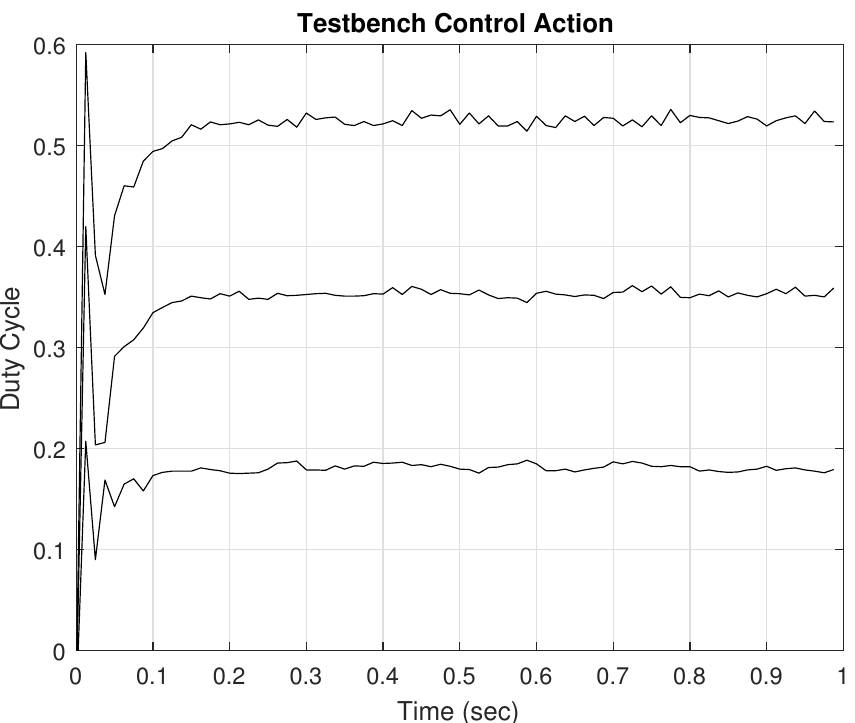
Figure 18. Control signal to the PVE